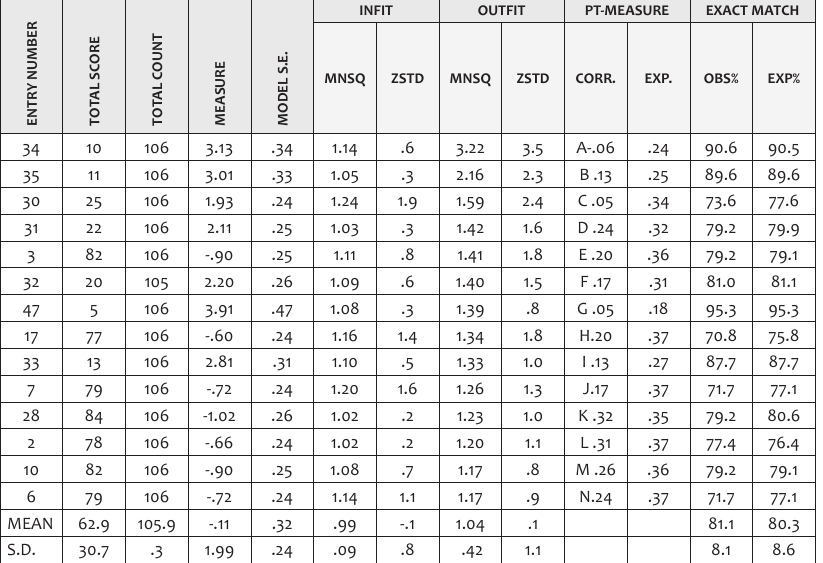
Table 2: Item statistics: misfit